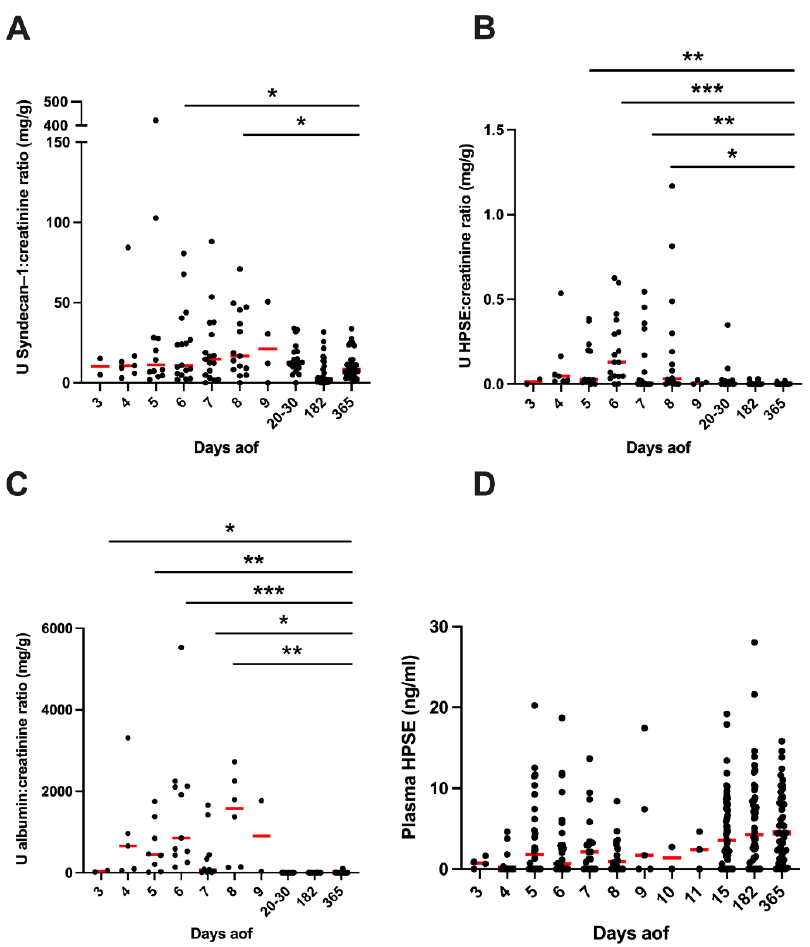
Figure 1. Heparanase and syndecan–1 levels during PUUV–HFRS. ( A ) Urinary syndecan–1:creatinine ratio ( B ), HPSE:creatinine ratio and ( C ) albumin:creatinine ratio. ( D ) HPSE concentration in plasma. Concentrations were measured from sequential samples of 49 (55 for plasma) patients hospitalized due to PUUV–HFRS (with a total of 159 urine and 262 plasma samples). Days after onset of fever (aof) 3–9 represent the acute stage, 20–30 the convalescent and 182–365 the controls. Differences between individual time points and the last time point (365 aof), which was considered to represent full recovery and used as controls, were assessed by GEE and significant differences indicated as *** <0.001, ** <0.01 and * < 0.05. Red lines represent mean ± standard